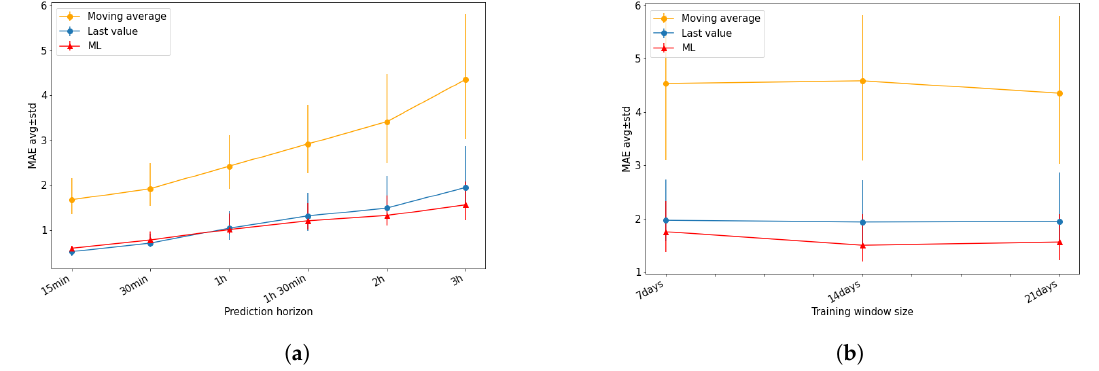
Figure 6. Comparison between ML-based vs. baseline approaches when varying prediction horizon or training window size. ( a ) effect of the prediction horizon (training window size: 21 days); ( b ) effect of the training window size (prediction horizon: 30